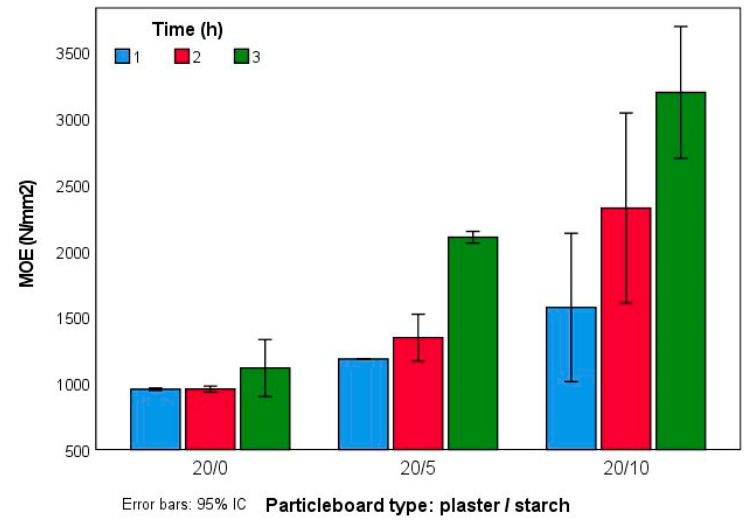
Figure 6. MOE values of the experimental panels.